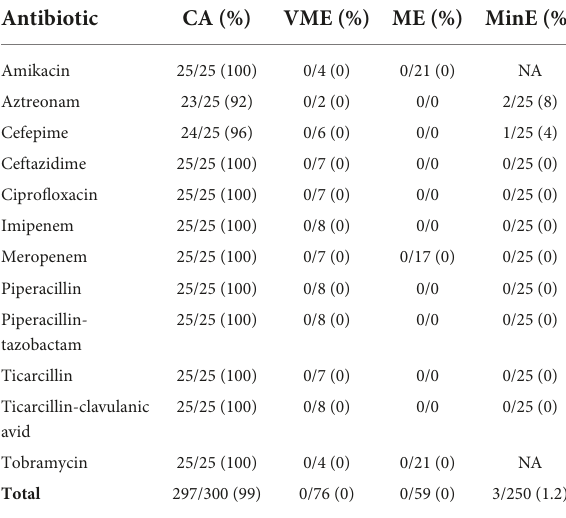
TABLE 5 Results from disk difffusion AST (filter paper disks, Bio-Rad) of 25 Pseudomonas aeruginosa from a liquid colony following FAST TM System testing on positive blood cultures in both study arms